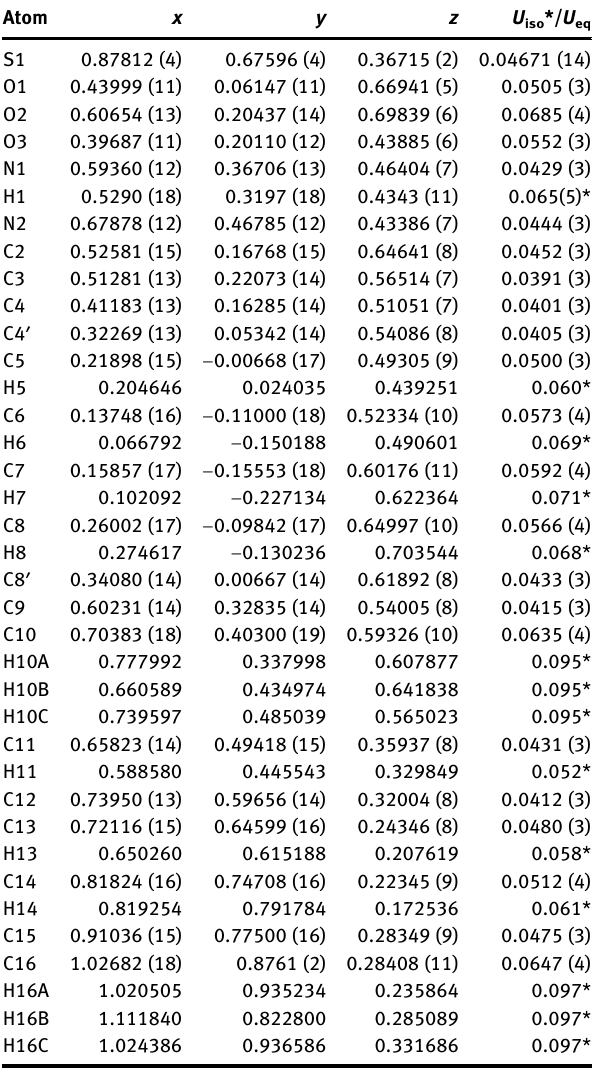
Table  : Fractional atomic coordinates and isotropic or equivalent isotropic displacement parameters (Å 